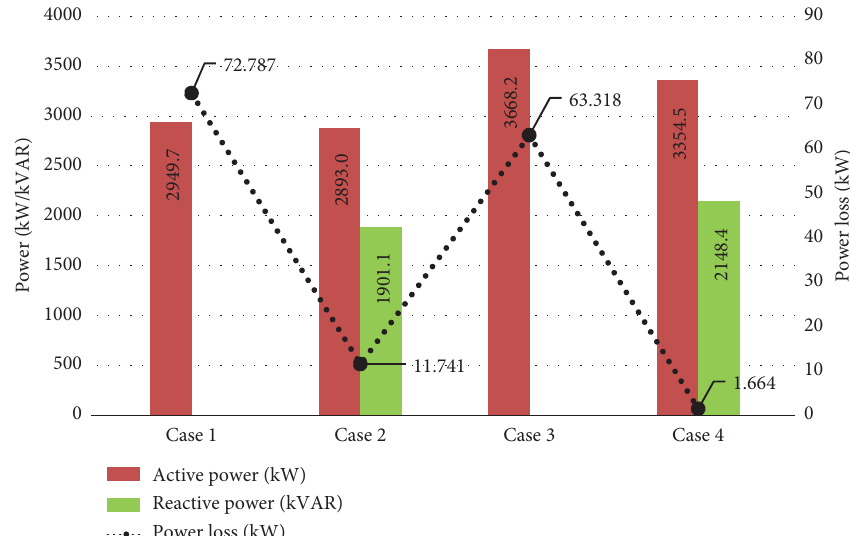
Figure 7: Power loss and power of PVUs for four cases of System 1.